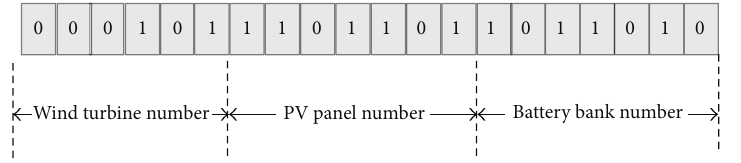
Figure 4: Binary coding of optimization